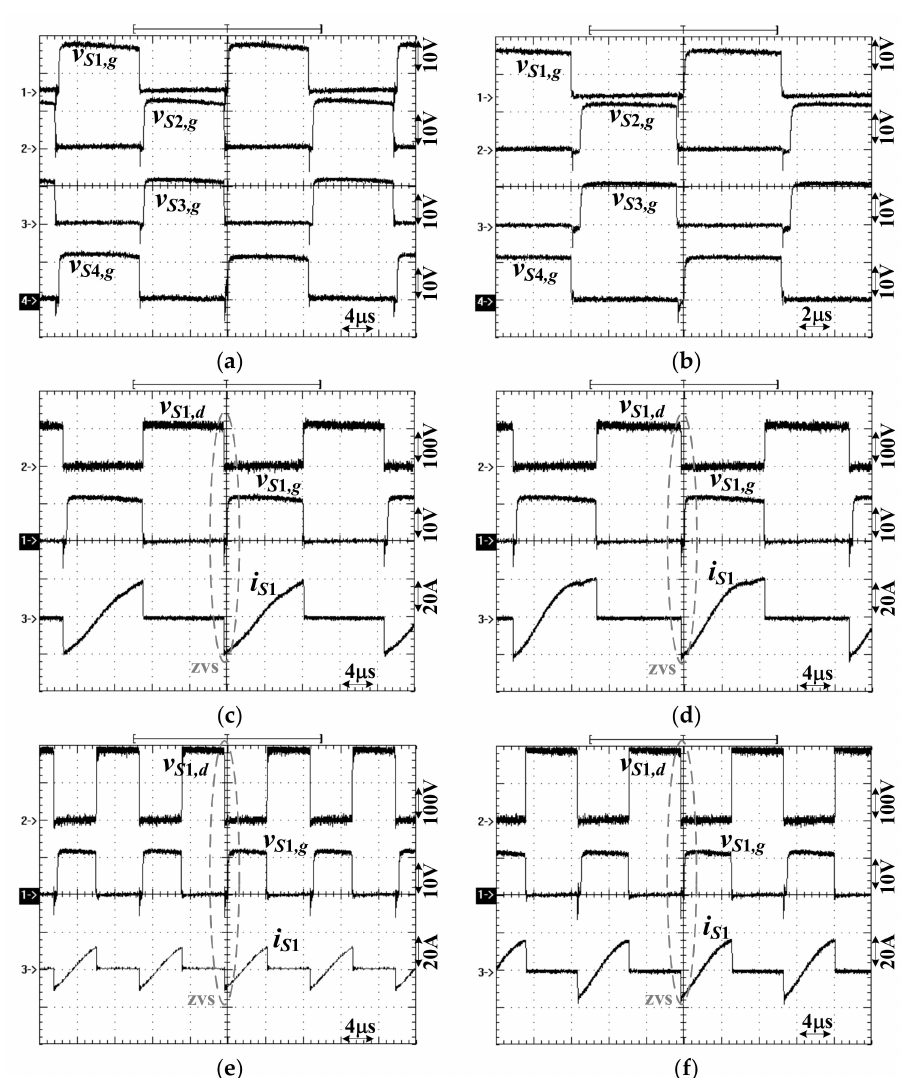
Figure 9. Experimental results of PWM signals for medium input voltage region: ( a ) S 1 – S 4 at 110 V input and 100% power; ( b ) S 1 – S 4 at 190 V input and 100% power; ( c ) S 1 voltage and current at 110 V input and 20% power; ( d ) S 1 voltage and current at V in = 110 V input and 100% power; ( e ) S 1 voltage and current at 190 V input and 20% power; ( f ) S 1 voltage and current at 190 V input and 100% power.